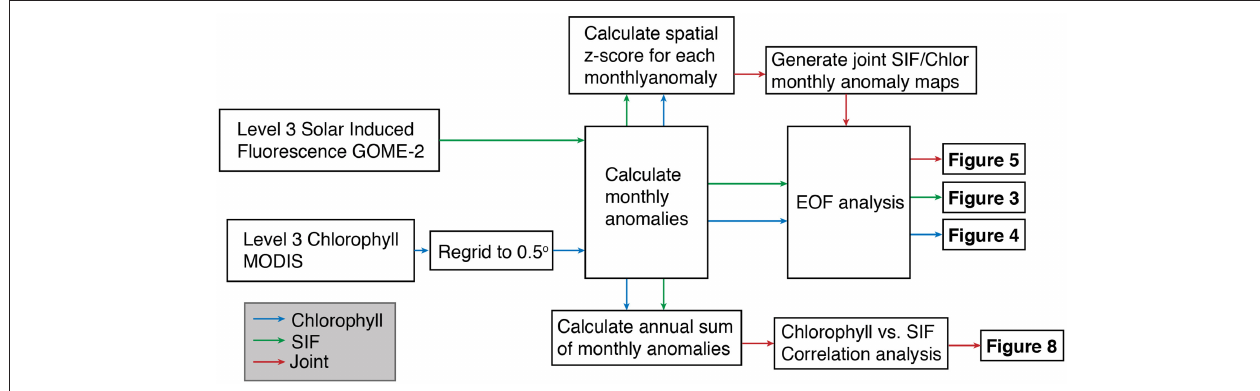
FIGURE 1 | Diagram showing workflow of analyses and the respective figures produced through these